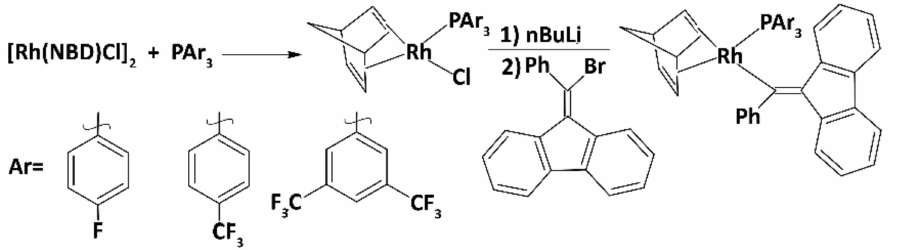
in combination with fluorine functionalized phosphine ligands.